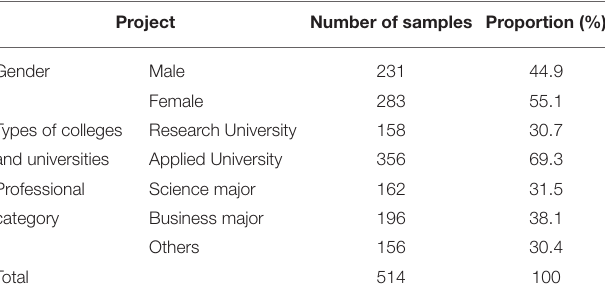
TABLE 2 | Basic sample statistical